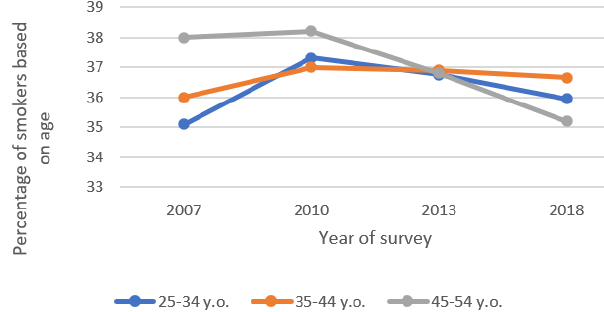
Figure 4. The trend of Smoking in Indonesia.